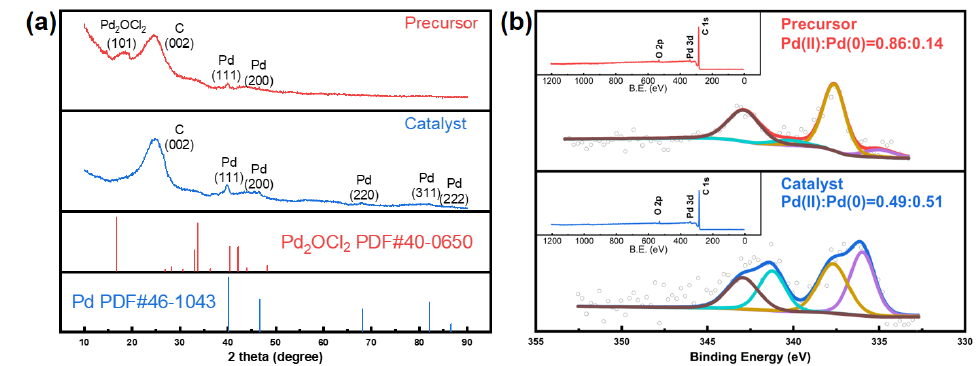
Figure 2. ( a ) XRD data for the pre-nucleation precursor and the catalyst by in situ reduction, along with the powder diffraction file of Pd and Pd 2 OCl 2 shown by vertical lines; the scan rate is 10°/min. ( b ) XPS data for the pre-nucleation precursor and the catalyst by in situ reduction, along with the valence analysis and full survey.